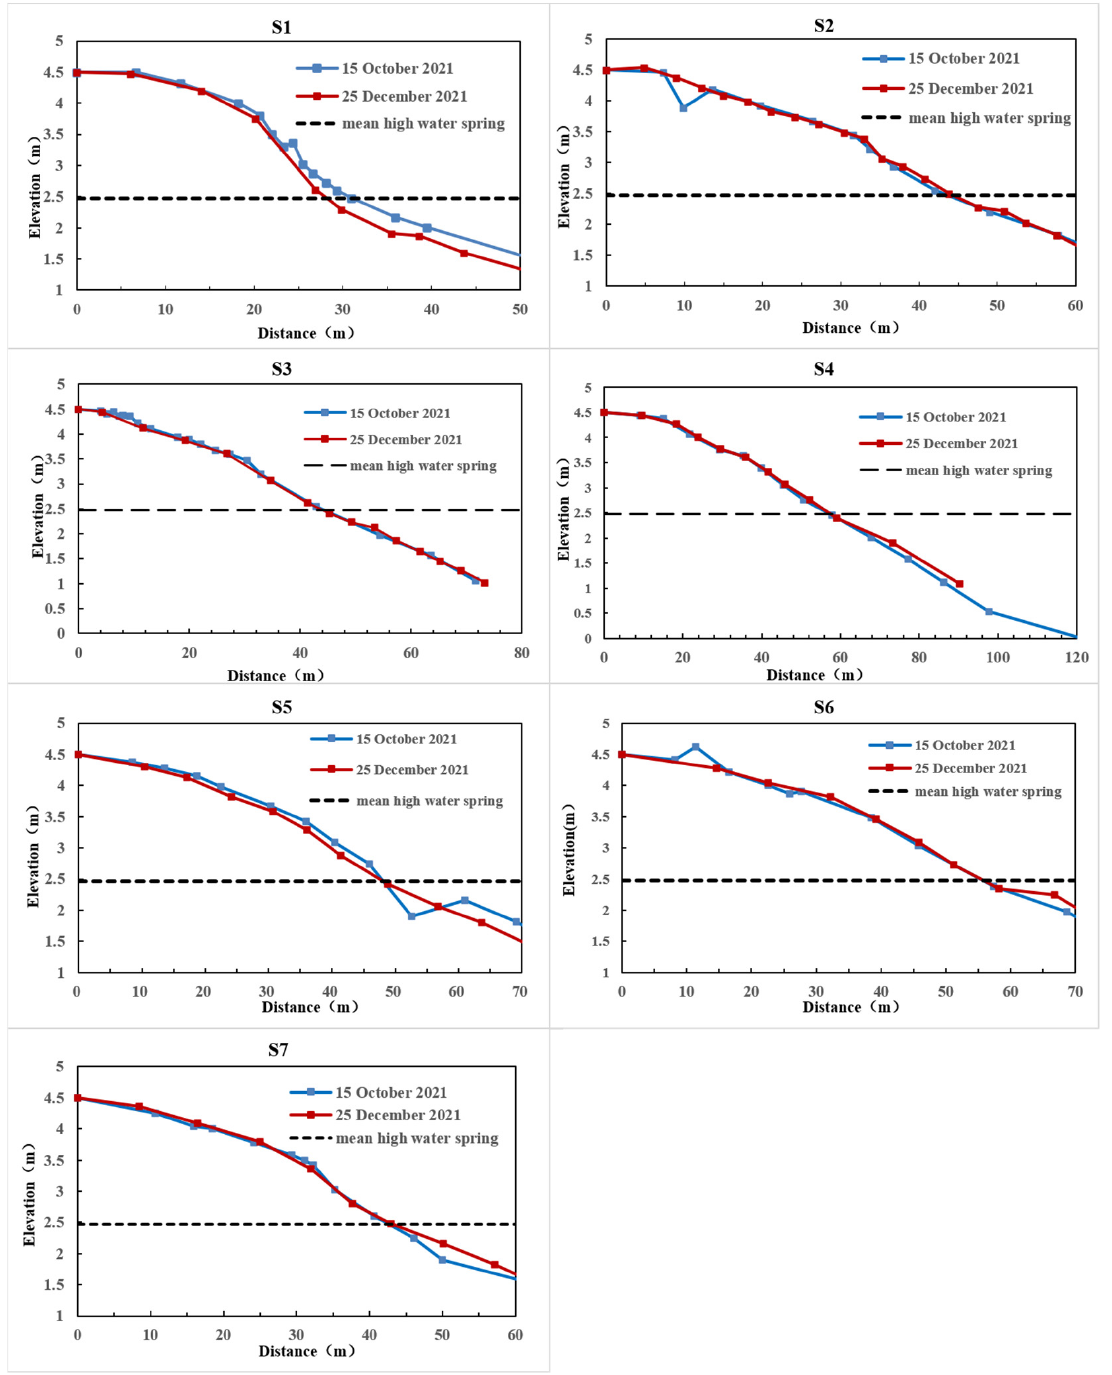
Figure 9. Sketch of the evolution of elevation of seven fixed profiles on the beach. The dashed line expresses the level of the mean high water spring. The red and blue solid lines are the monitoring profiles after October and December. Furthermore, the blue line can be regarded as an initial profile to the red one.